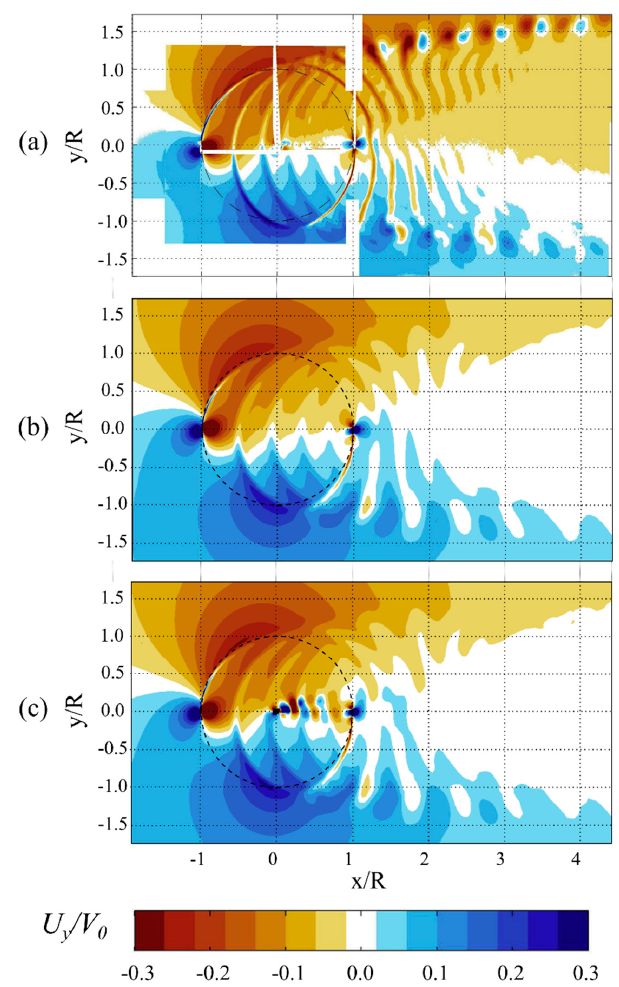
Figure 10. Contour maps of the U y velocity component, shown for ( a ) PIV [26]; ( b ) the rotor without shaft; ( c ) the rotor with shaft.